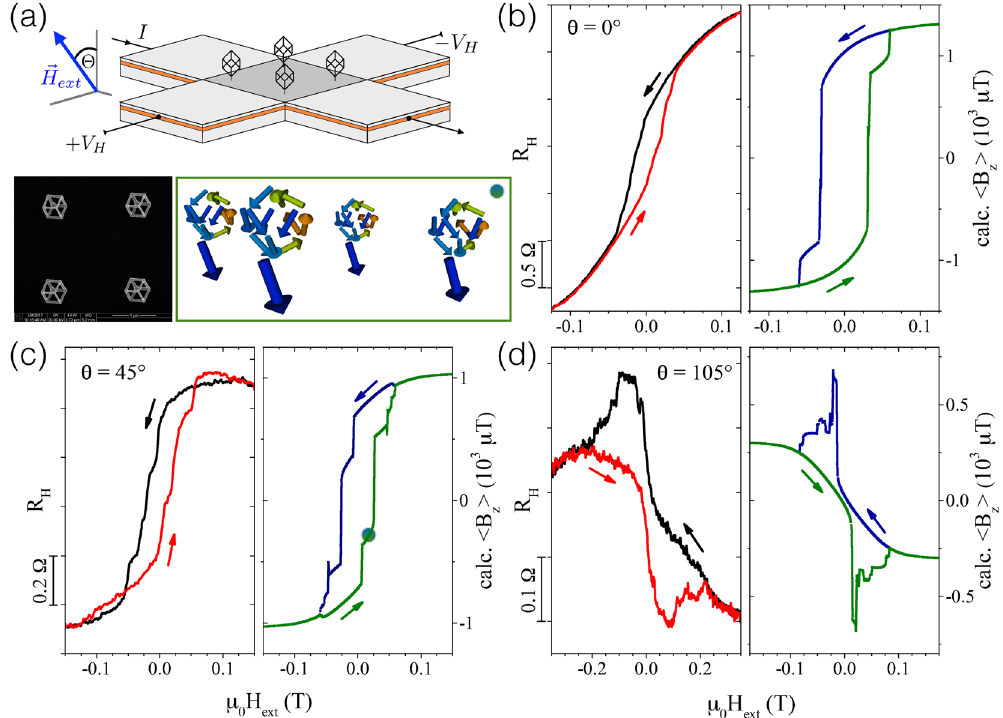
Figure 4. Micro-Hall magnetometry measurement results and macro-spin simulations of CoFe nano-cubes. ( a ) Sketch of a 2 × 2 array of CoFe nano-cubes on a 5 × 5 μ m 2 Hall cross with the external magnetic field H ext applied at an angle θ relative to the surface normal of the sensor (top). Bottom: SEM micrograph of the nano- cubes (top view) directly written by FEBID on top of the Hall sensor (left) and configuration of the magnetic moments from macro-spin simulations for θ = 45° (right) shown in ( c ). The circle marks the position at a positive field in the up-sweep, just before the switching of the stem. ( b – d ) magnetic hysteresis curves measured as R H vs. μ 0 H e xt at T = 30 K compared to calculated stray fields from macro-spin simulations for T = 0 K for a selection of inclination angles θ equal to 0°, 45° and 105°, respectively. Arrows indicate the direction of field sweeps. Note different scales of the magnetic field axes in ( d